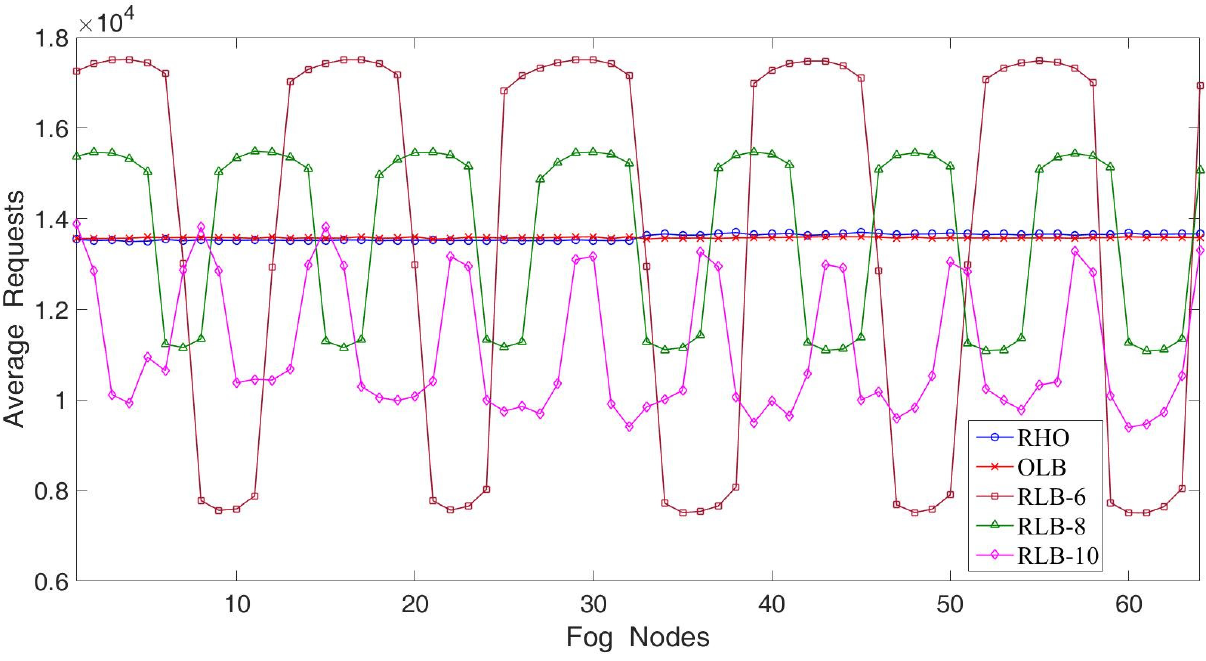
Figure 7. The average requests where thirty-two fog nodes have high loads of hotspot services.